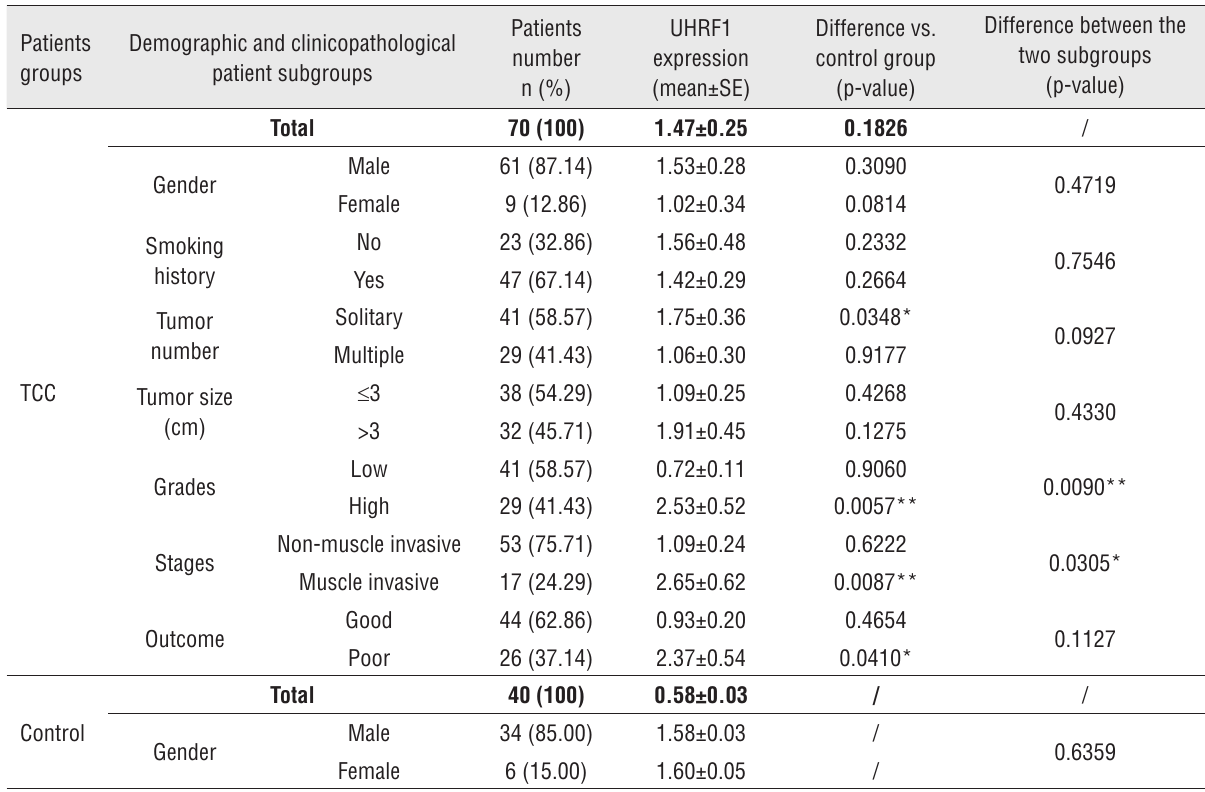
Table 1 - UHRF1 gene expression values regarding the demographic and selected clinicopathological parameters in urinary bladder TCC versus control patient’s samples and differences between the urinary bladder TCC subgroups.